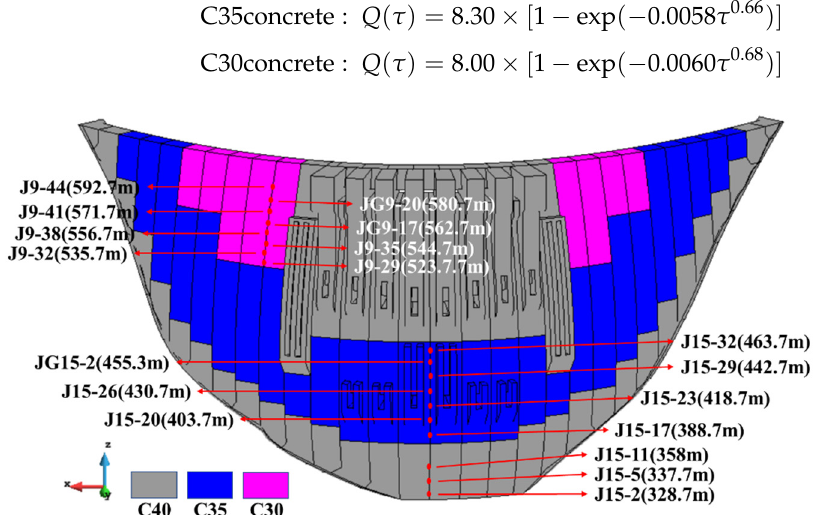
Figure 9. The location of the joint meters inside the dam.